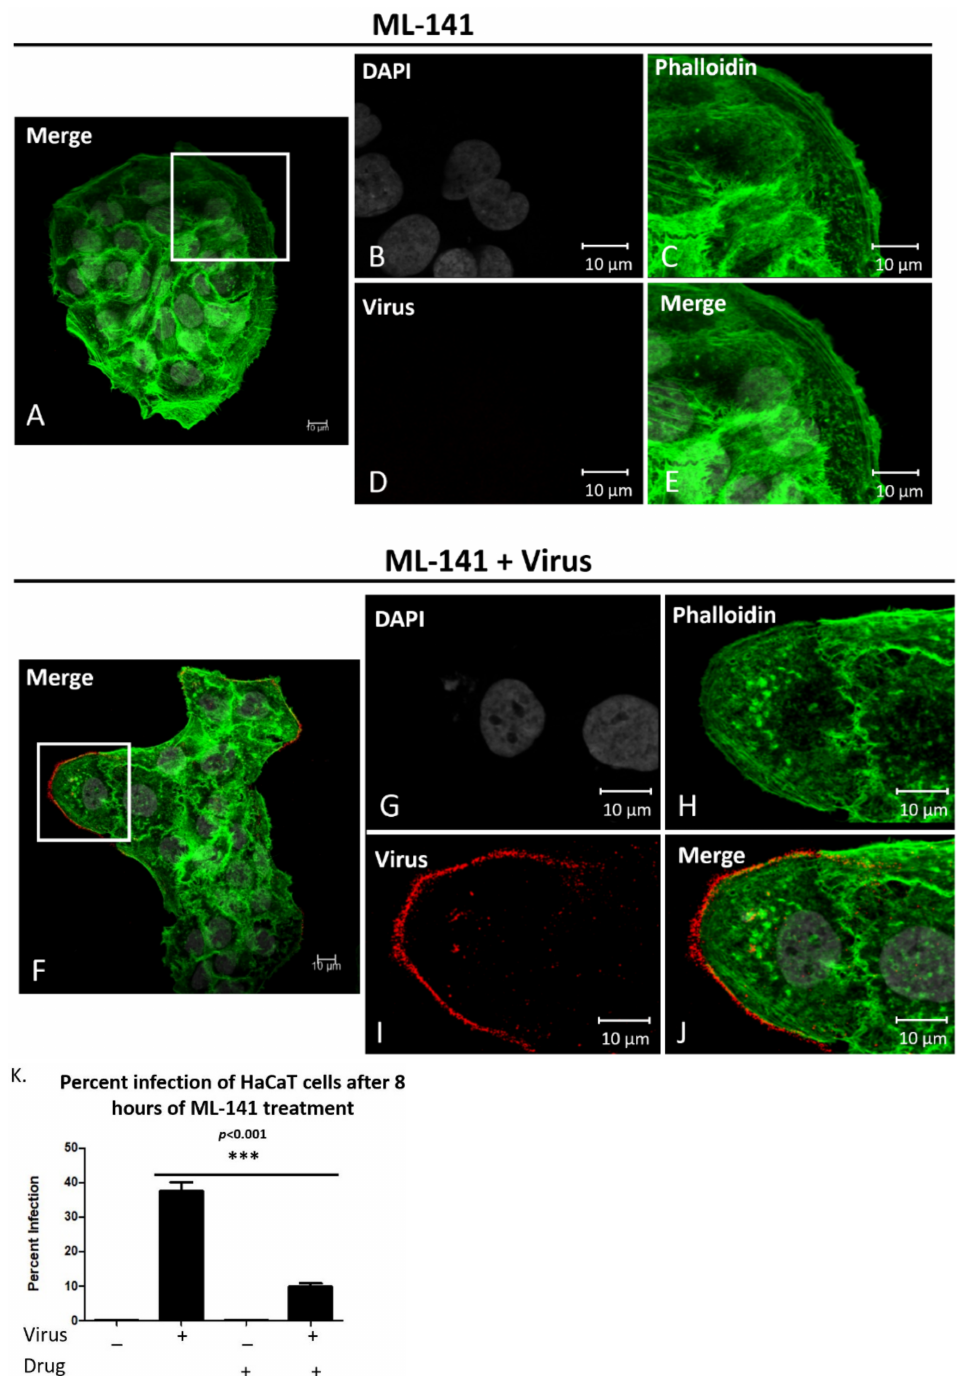
Figure 4. ML-141 treatments inhibit filopodia and decrease HPV16 infection in HaCaT cells. Con- focal microscopy images of cells treated with 10 µ M ML-141 ( A – E ) or treated with both drug and virus ( F – J ) for 2 h at 37 ◦ C. Nuclei stained with DAPI (grey), F-actin visualized with phalloidin (green), and L1 capsid protein stained with H16.V5 (red). Merged images of all channels ( E , J ). Virus binds along the outside of the HaCaT cell membranes that lack filopodia ( H ). Percent infection with or without drug treatment was measured with flow cytometry ( K ). Data was taken from three individual experiments in triplicate. Statistical differences determined by ANOVA Dunnett’s multiple comparison test, (samples compared to control infection, n = 9, *** p < 0.001). Average was displayed with